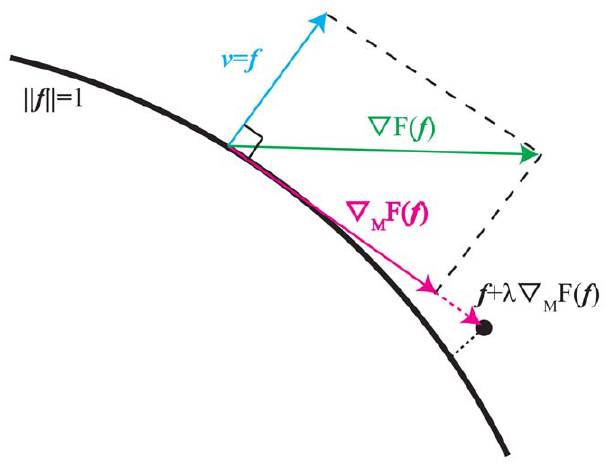
Figure 5. Loading condition on manifold surface. v is a normal vector of E f E ~ 1 and is equal to f